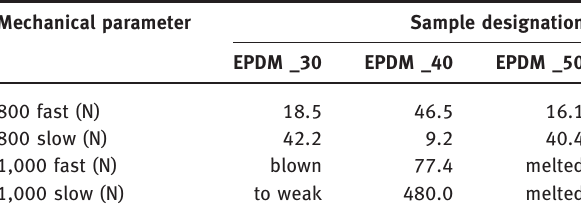
Table 5: Force required to crush ceramic residue created after heat treatment of samples